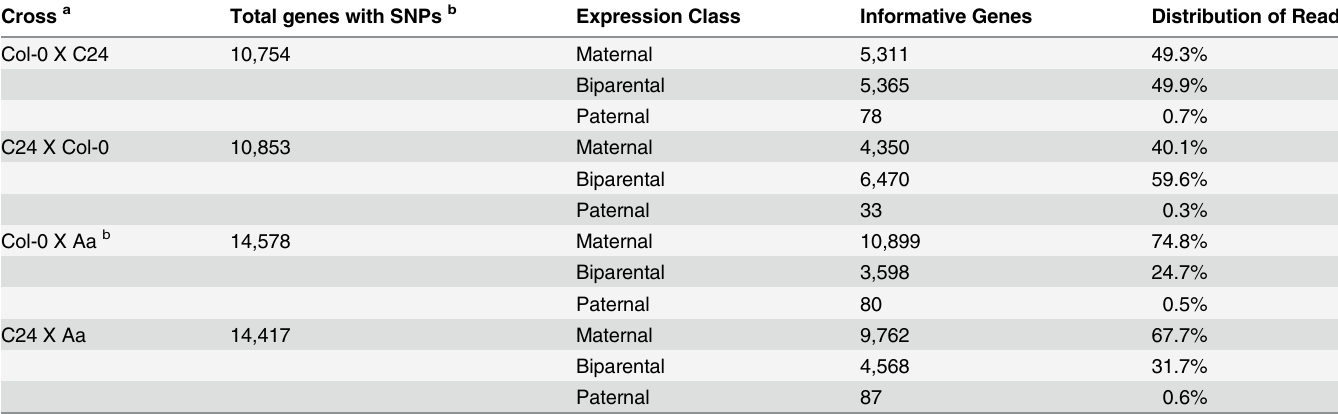
Table 1. Parentally biased expression of 3 DAP Arabidopsis. Cross a